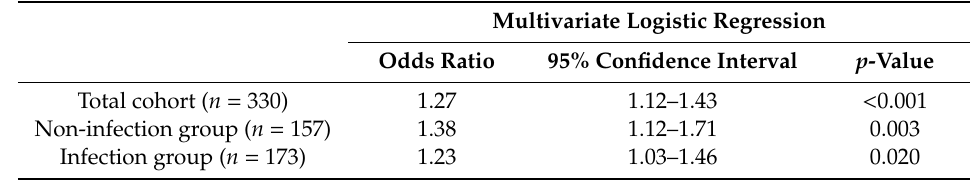
Table 3. Th independent role of procalcitonin in predicting acute kidney